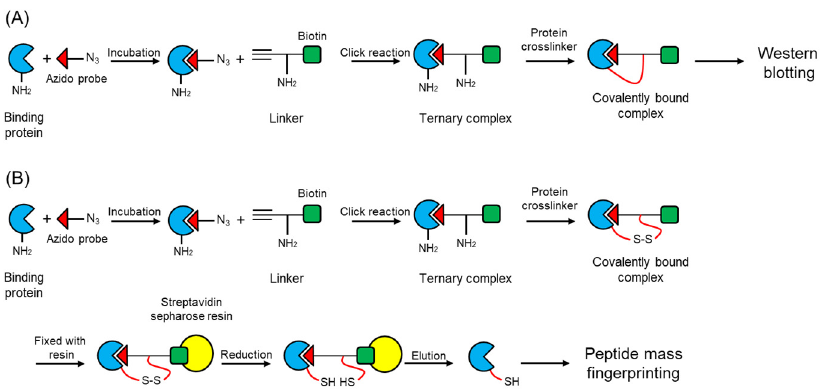
Figure 2. Illustration of the methods used for identifying a target protein using a probe with an azido group. ( A ) Chemical labeling; ( B ) Identification of a target protein.This complex is unable to be dissociated under physiological conditions. A target protein in the stable covalently bound ternary complex was detected by Western blotting using streptavidin conjugated with horseradish peroxidase (Figure 2A). Moreover, after the click reaction, the ternary complex was covalently fixed with a protein cross-linker with an intramolecular disulfide bond such as dithiobis(sulfosuccinimidyl propionate) disodium salt (DTSSP, 4 , Figures 1 and 2B). The covalently bound ternary complex was immobilized with a streptavidin resin. Non-specifically associated proteins with the affinity matrix were washed thoroughly, and the disulfide bond was then cleaved by a reducing agent, resulting in the release of the target protein from the affinity matrix (Figure 2B). The eluted proteins were analyzed by peptide mass fingerprinting. The method described above succeeded in identifying a recombinant AtPYL2 from a protein extract of E. coli that overexpressed AtPYL2